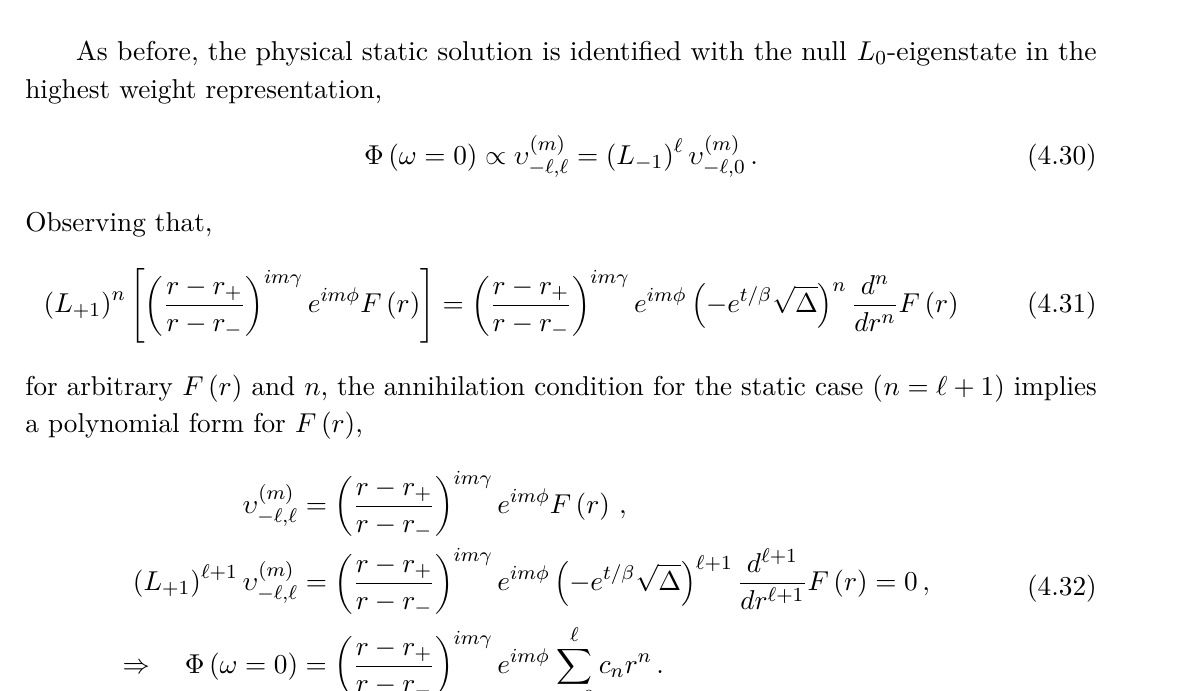
Figure 3 . The infinite-dimensional highest and lowest weight representations of SL (2 , R ) whose elements solve the near zone equations of motion for a massless scalar field in the Kerr-Newman black hole background with multipolar index ‘ and contain the static